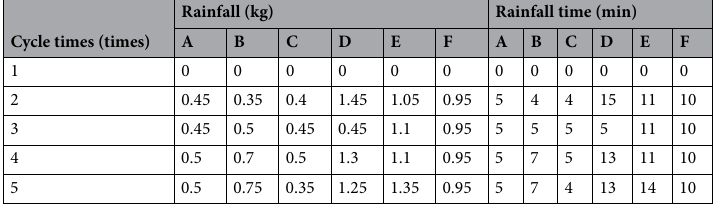
Table 2. Rainfall and rainfall time for each group.